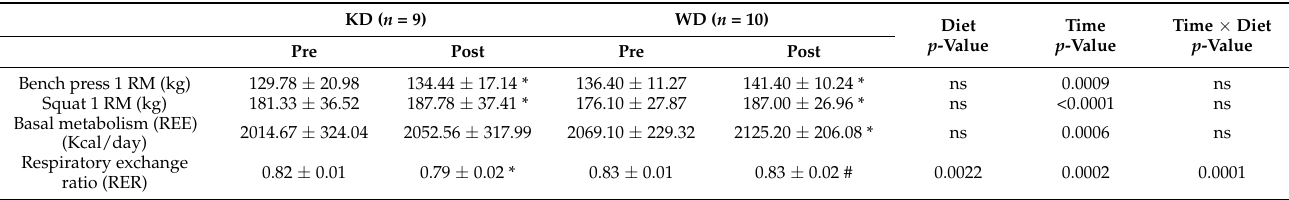
Table 3. Muscle strength and basal metabolism results.